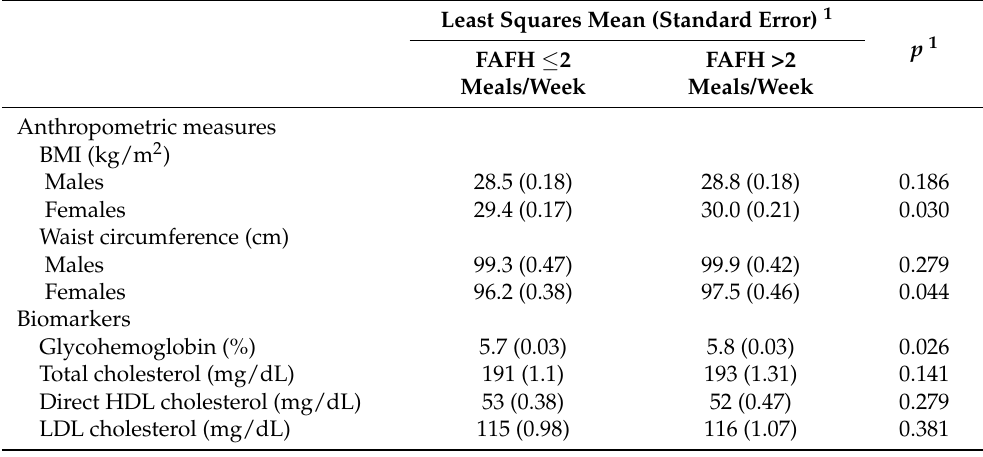
Table 3. Differences in anthropometric measures and biomarkers of chronic disease by FAFH frequency. Least Squares Mean (Standard Error)